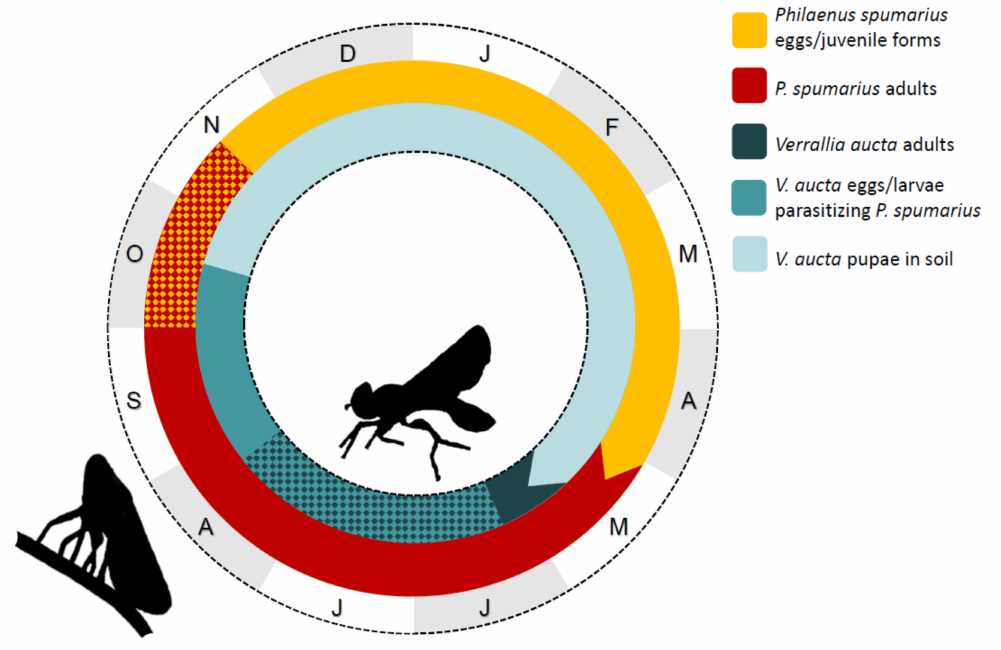
Figure 5. Life cycle of Verrallia aucta on Philaenus spumarius in the plain–foothill zone of northern Italy over the year (initials of months in capital